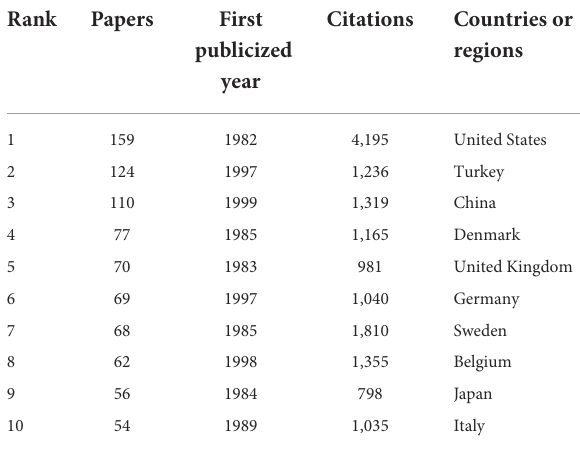
TABLE 1 The top 10 countries or regions on publications on NE from 1982 to